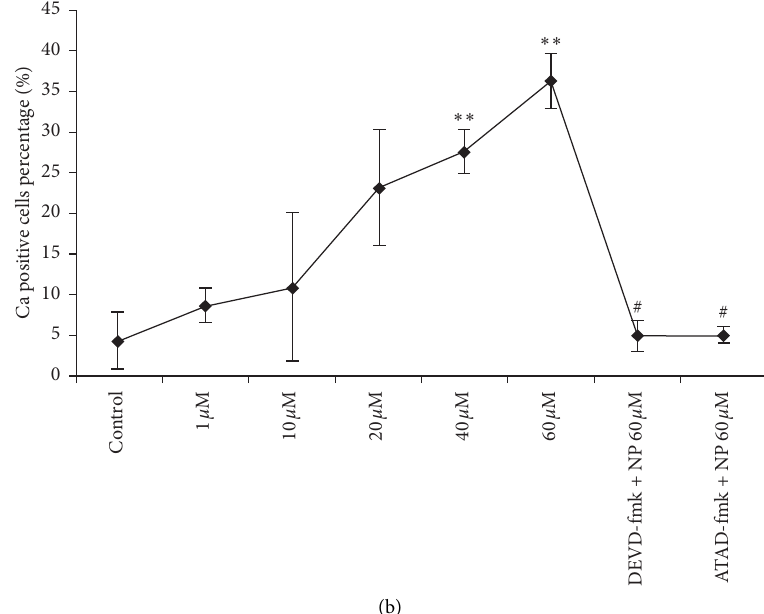
Figure 6: NP-induced Ca 2+ release in NCTC Clone 1469 cells. The appearance of Ca 2+ release was detected by flow cytometry using Fluo-3/ AM fluorescent probe. For each sample, 20,000 cells were analyzed. (a) Flow cytometric plots. (b) Flow cytometric analysis result. Results are presented as mean ± SD with triplicate measurement. ∗ P < 0 . 05, ∗∗ P < 0 . 01 versus the control group, # P < 0 . 05 versus 60 μ M NP group.